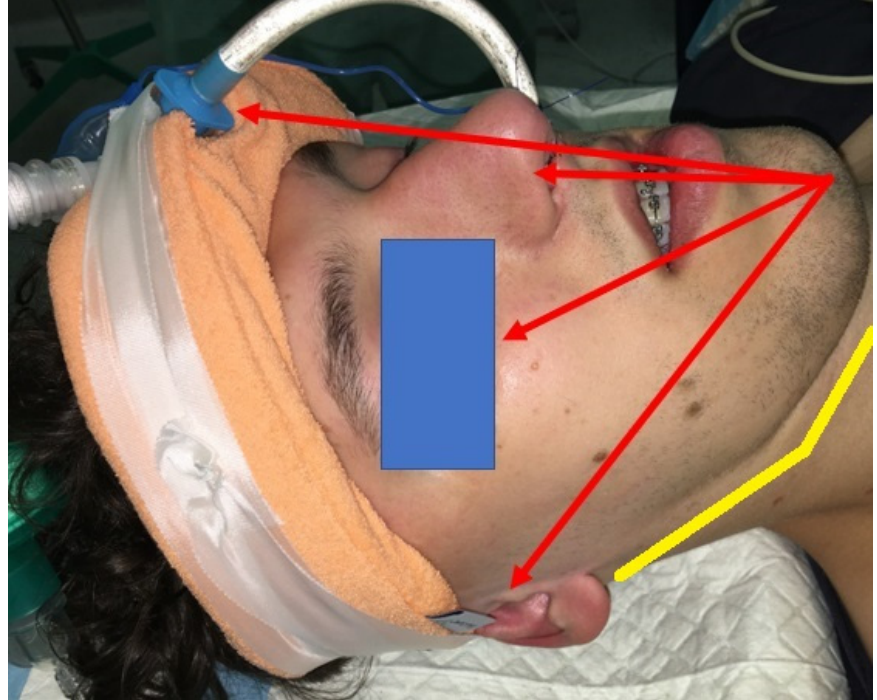
Figure 2. Placement of the stabilized NTI—red arrows show the accurate positioning of the